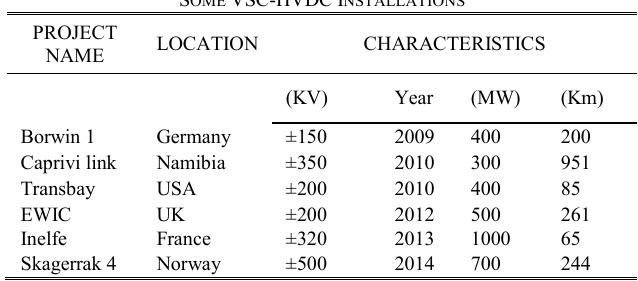
Fig. 4. Simplified PQ characteristic of a VSC HVDC terminal [42] TABLE II S OME VSC-HVDC I